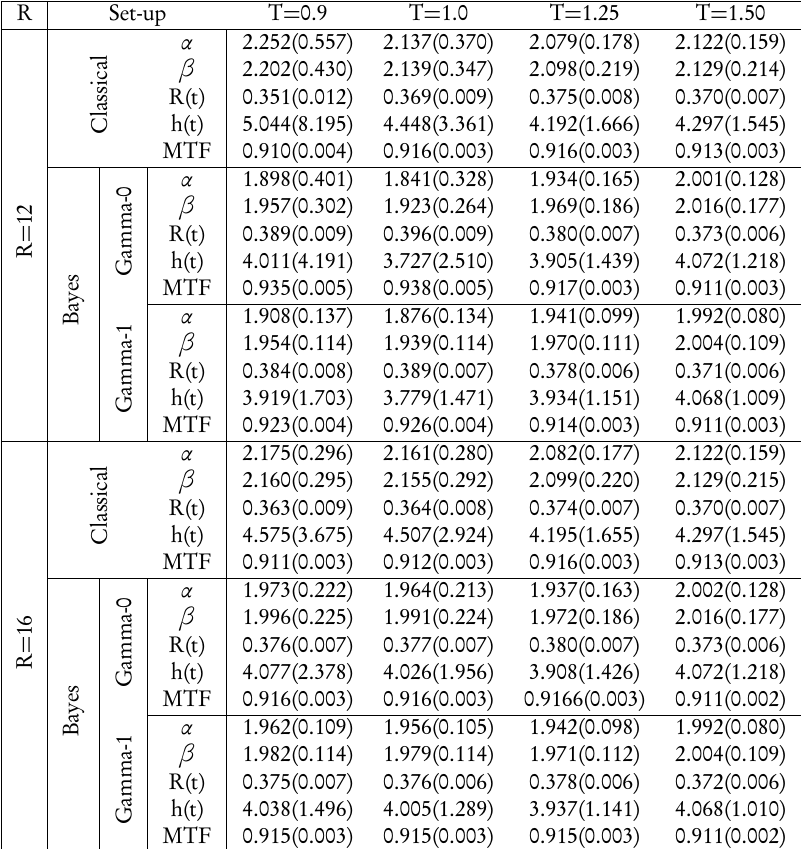
Average estimates of the parameters, reliability, hazard and MTSF and corresponding MSEs (in brackets) with varying R and T for fixed n = 20 , α = 2 , β = 2 , R ( 1 ) = 0.368 , h ( 1 ) = 4 and MTF = 0.910